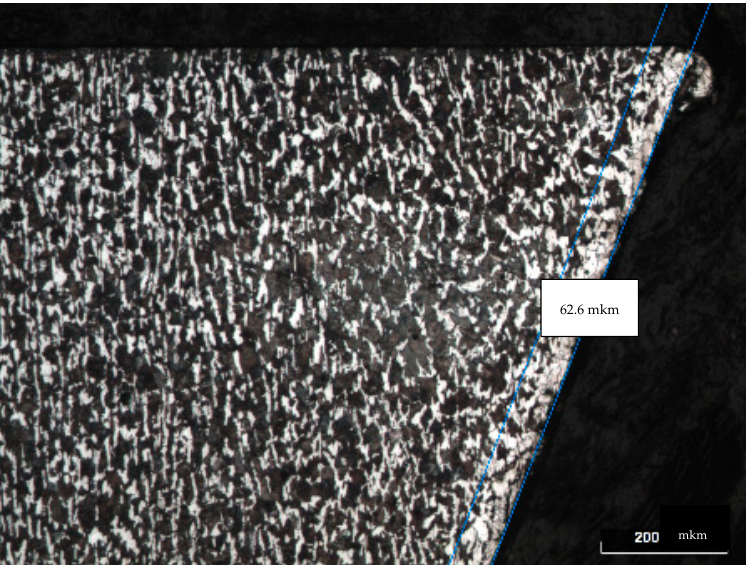
Figure 5. An image of the transverse structure of the microscope of the Nd: YAG laser-treated steel surface obtained with an optical microscope. Sample No. 12.